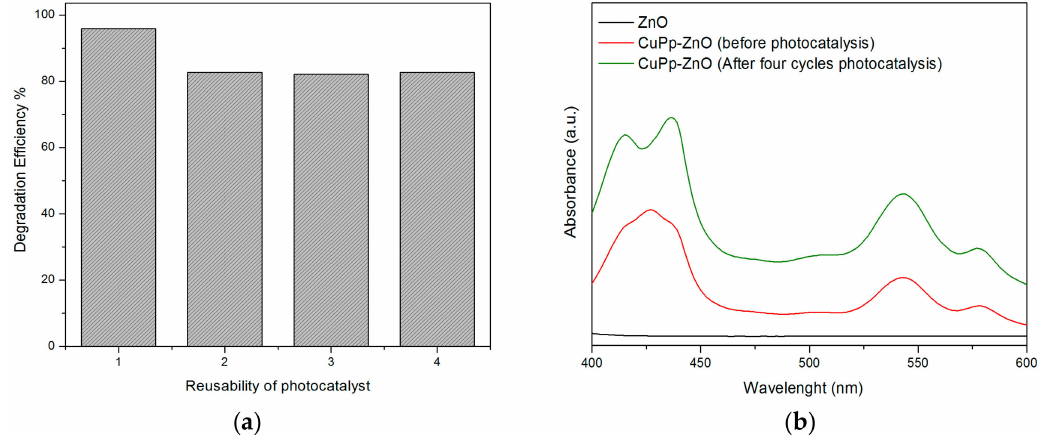
Figure 8. Reusability of CuPp-ZnO in the photodegradation of RhB ( a ); and UV-Vis diffuse reflectance spectra after last cycle of CuPp–ZnO photocatalyst ( b